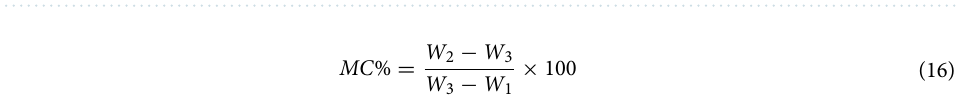
Figure 16. Measuring of sensing capability ( a ) Filling MPA channels by sand with different levels of moisture, ( b ) Changing absorption characteristics by varying the soil